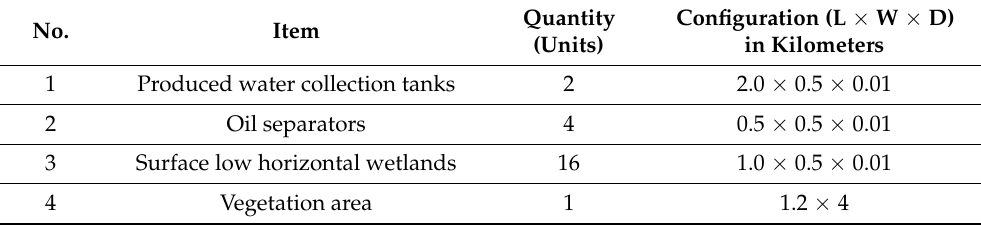
Table 3. The elements of the potential